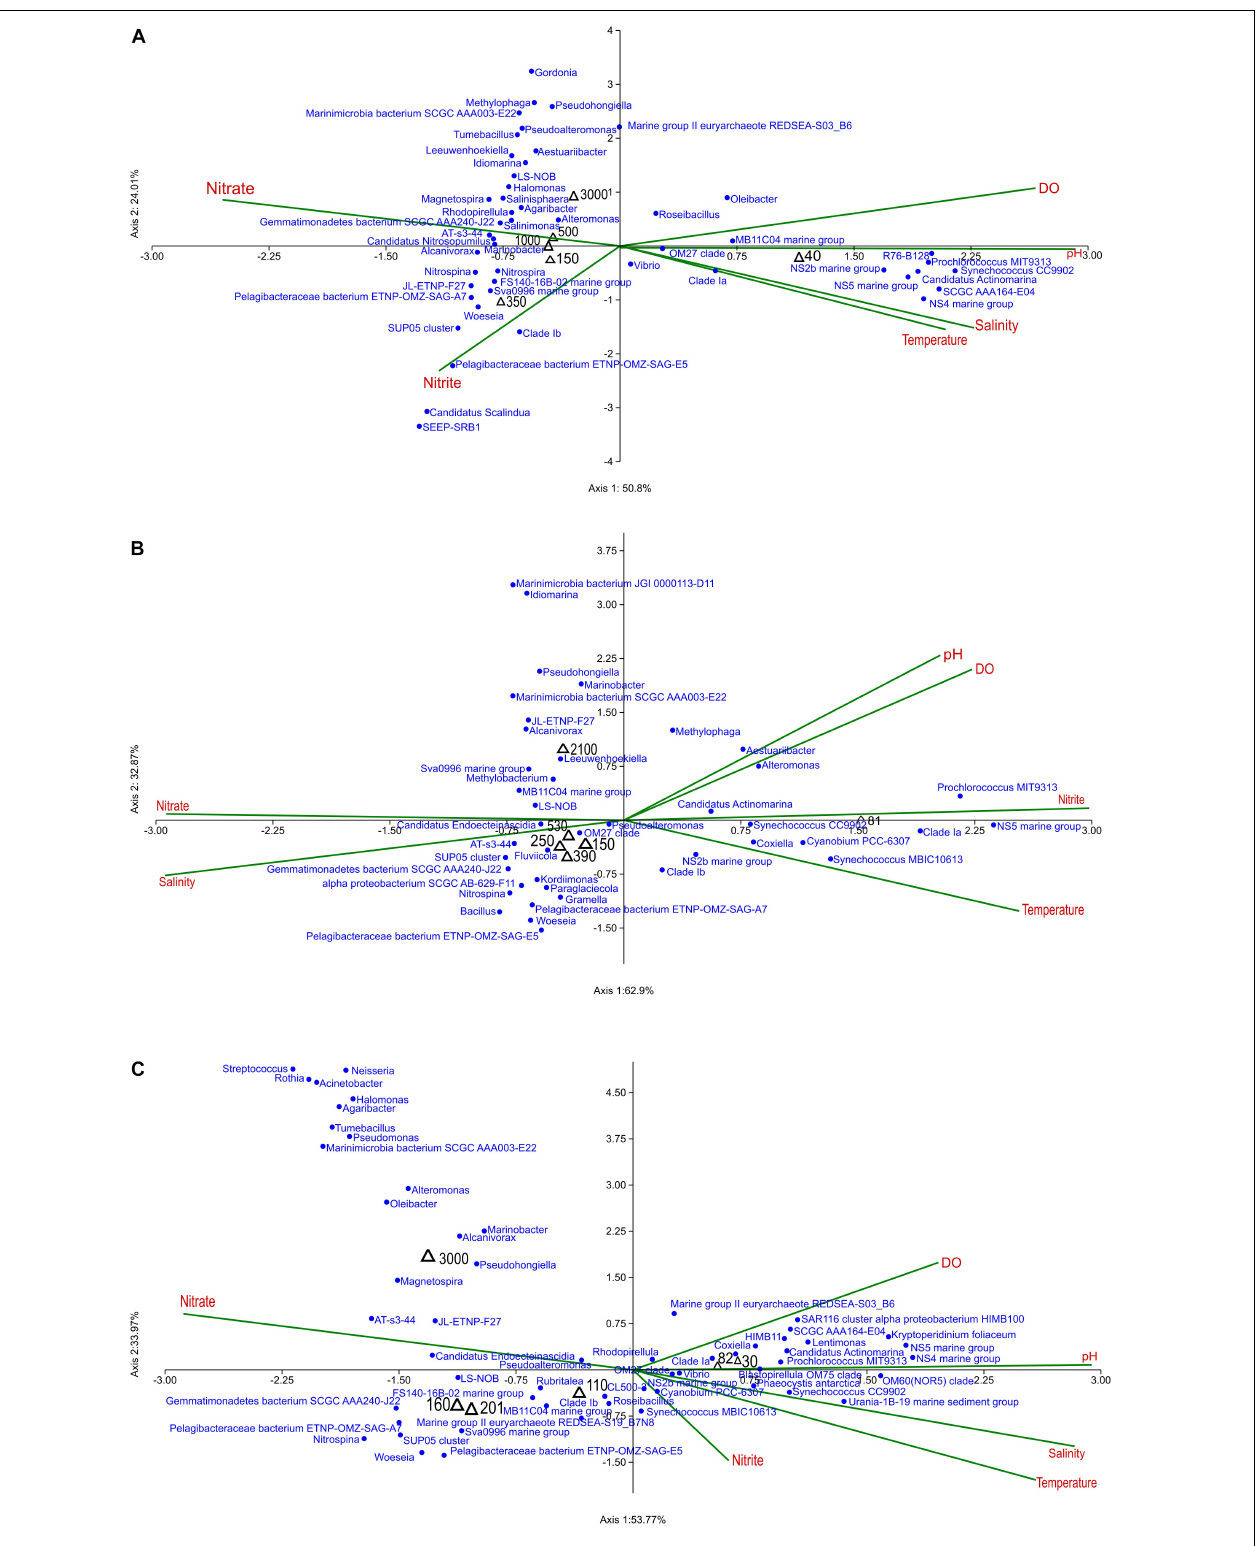
FIGURE 5 | Canonical Correspondence Analysis ordination diagram of bacterial communities at generic-level at (A) Arabian Sea time series (ASTS), (B) Bay of Bengal time series (BoBTS), (C) India’s Idea 2 (II2) associated with environmental parameters. In red is the environmental parameters, black is depths sampled and blue is bacterial